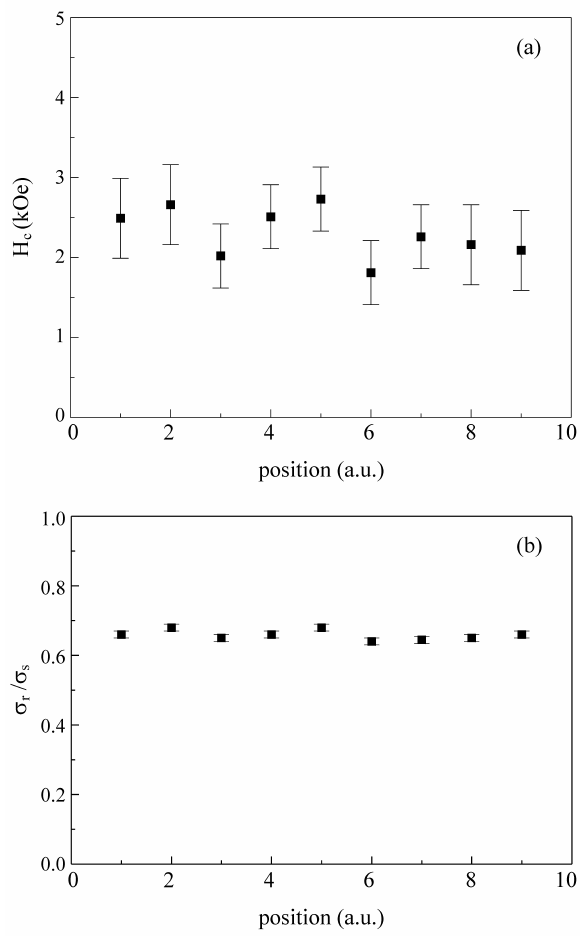
Figure 4. Magnetic characterization for the pieces 1 to 9 of a sample which was flash-annealed at 640 °C: (a) H c values; (b) σ r / σ sat values.